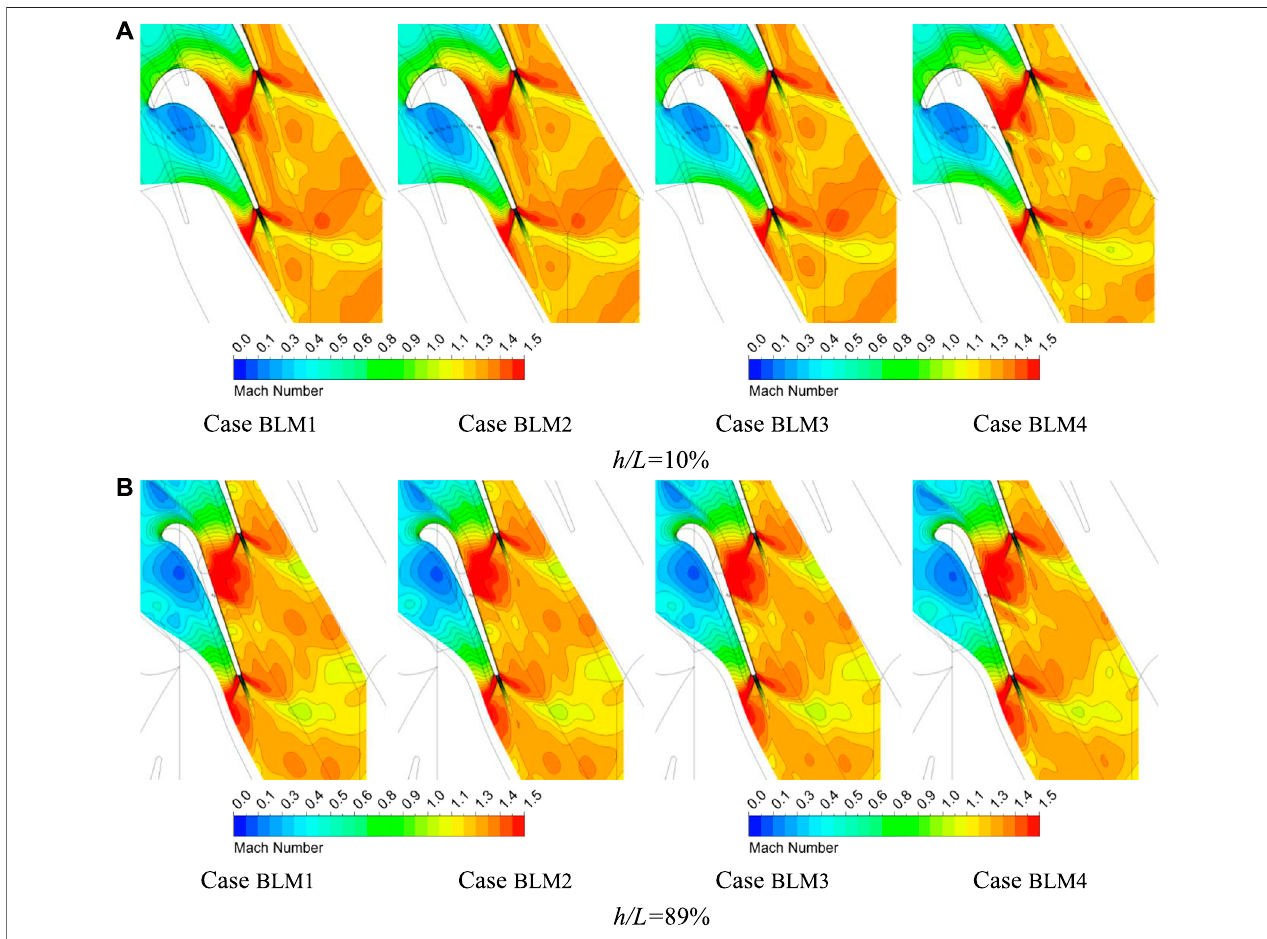
FIGURE 10 | Mach number contours in different height sections of low-degree-of-reaction (DOR) blade airfoil. (A) h/L = 10% and (B) h/L = 89%.